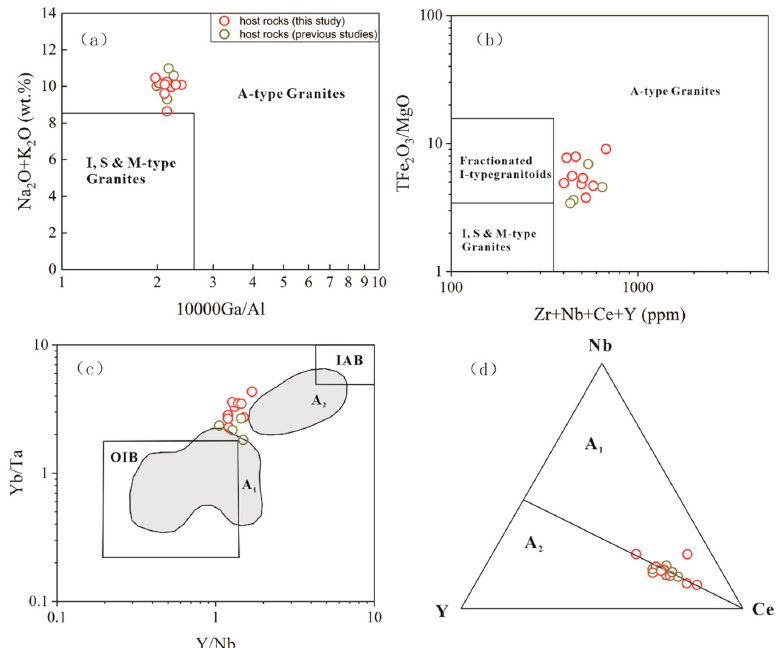
Figure 8. Chemical classification of rocks from the Muchen rocks. ( a ) 10,000 Ga/Al versus Na 2 O + K 2 O (wt.%) diagram [16]. ( b ) (Zr + Nb + Ce + Y) (ppm) versus TFe 2 O 3 /MgO diagram [16]. ( c ) Y/Nb versus Yb/Ta diagram, gray fields represent A 1 - and A 2 -type granites of [72]. ( d ) Y-Ce-Nb diagram, dashed line corresponds to Y/Nb ratio of 1.2 [73]. Previous data of Muchen rocks from Liu et al. [30].